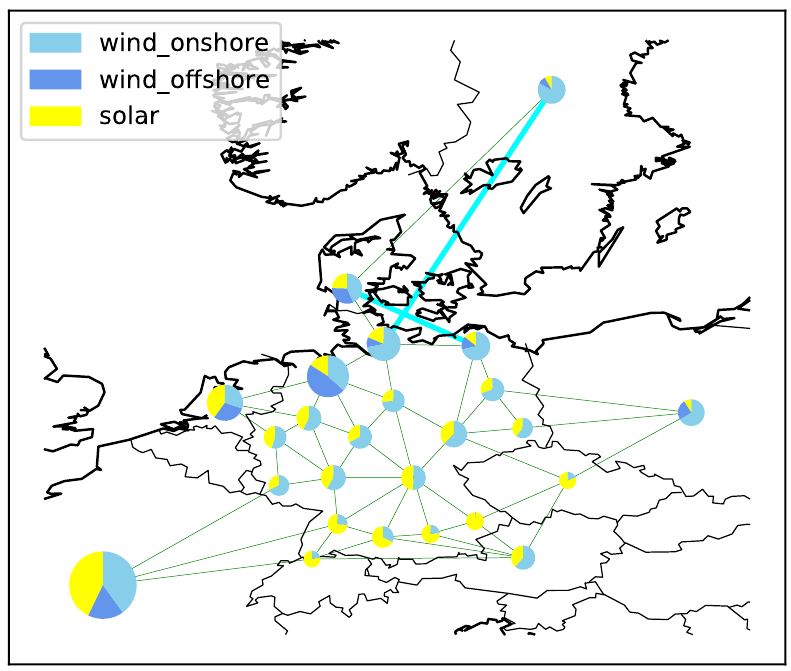
Figure 3. Installed capacity of selected renewable energy sources by region. The size of the dot represents the installed capacity in MW. Note: The full network has been clustered to 25 buses for better